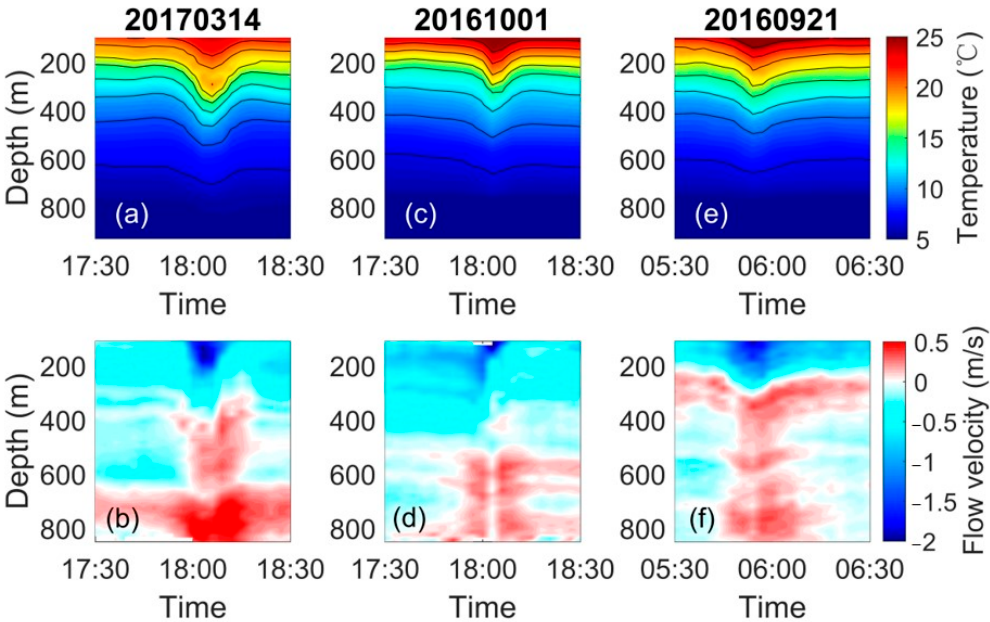
Figure 2. Temperatures and flow velocities for ISWs passing by the IW5 station on three different days. ( a , c , e ) Temperatures measured by thermistor chains. ( b , d , f ) Flow velocities measured by the ADCPs. The flow velocity from west to east is positive and the reverse is negative. The flow velocity in this work refers to the zonal velocity. All data sampled at UTC+8.